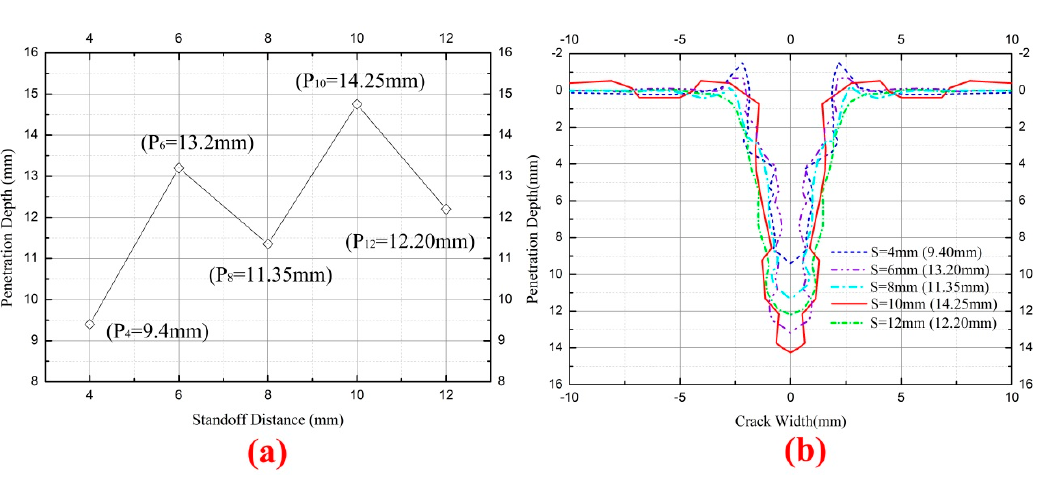
Figure 16. Penetration depth of BLSCs with different standoff distance: ( a ) Penetration depth of various standoff distance; ( b ) Sectional penetration crack.